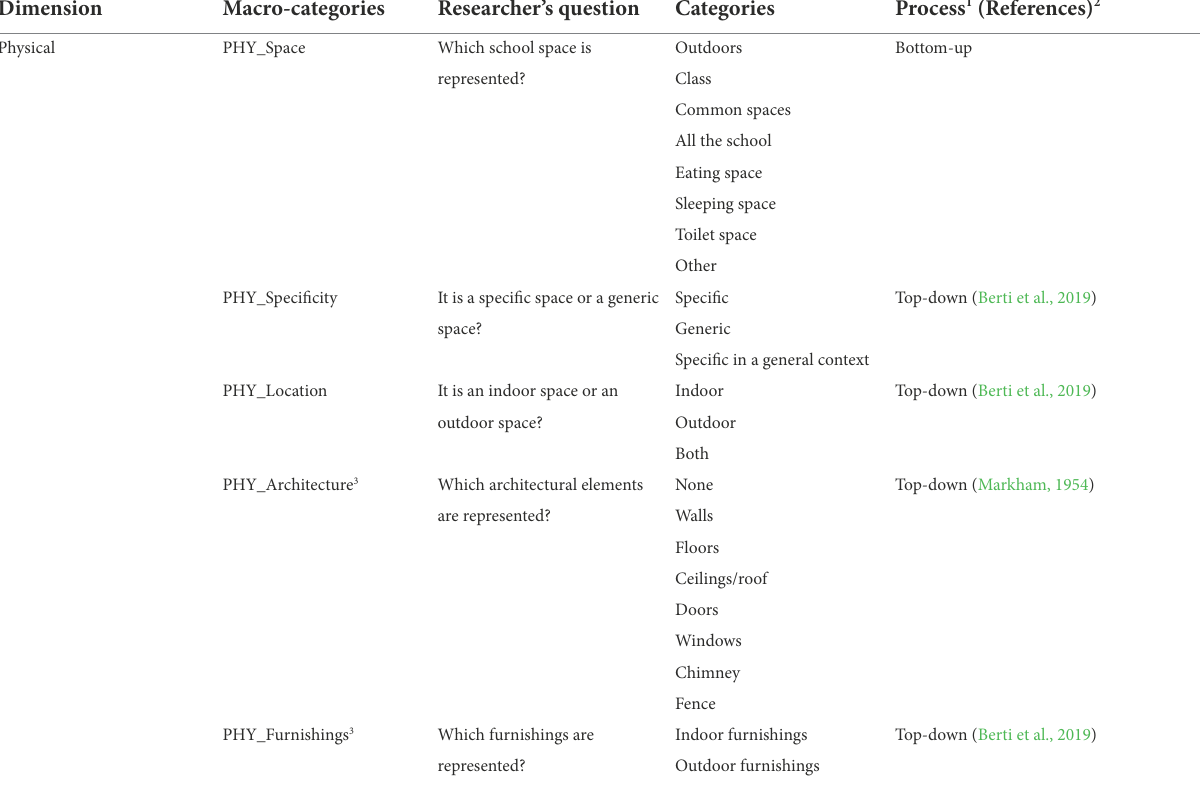
TABLE 1 Physical dimension: macro-categories and categories included in the DRAW.IN.G. grid. Dimension